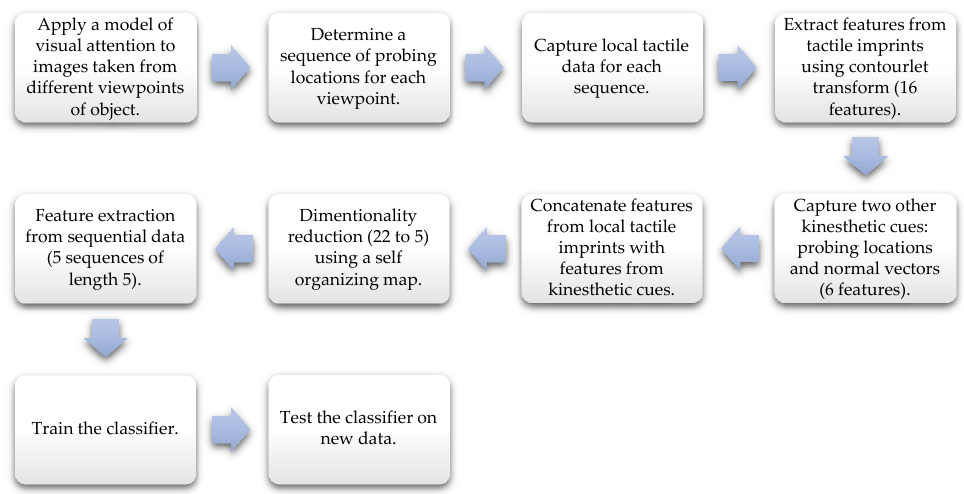
Figure 1. Framework of the introduced tactile object recognition